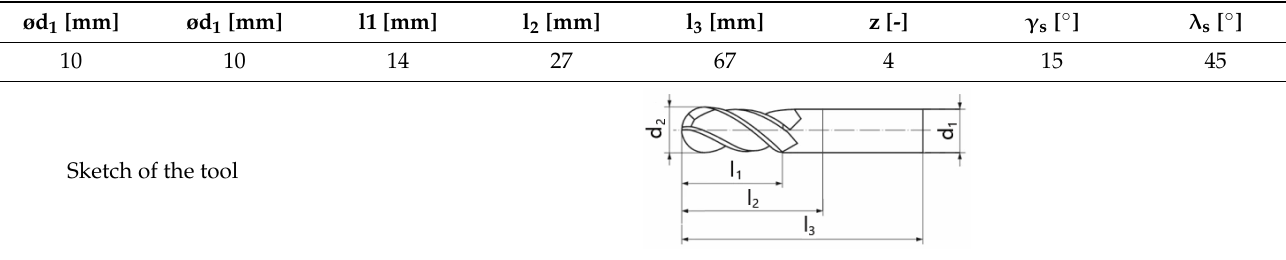
Table 1. Parameters of the ball-end mill tool [19].